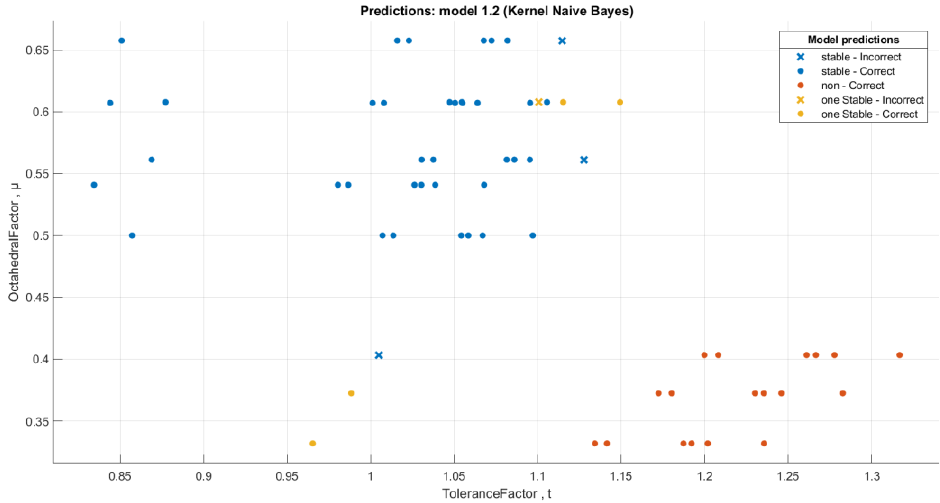
Figure 13. The Kernel Naive Bayes classifier prediction model for the data with stability conditions.